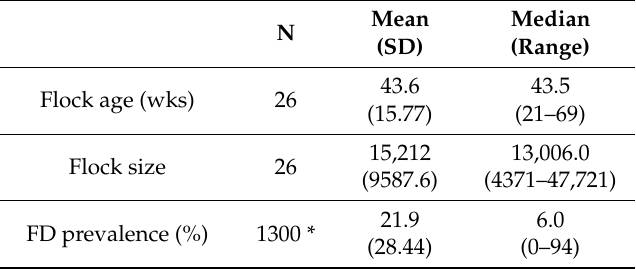
Table 3. Description of 26 laying hen flocks housed in furnished cages by average age, flock size and prevalence of feather damage (FD).